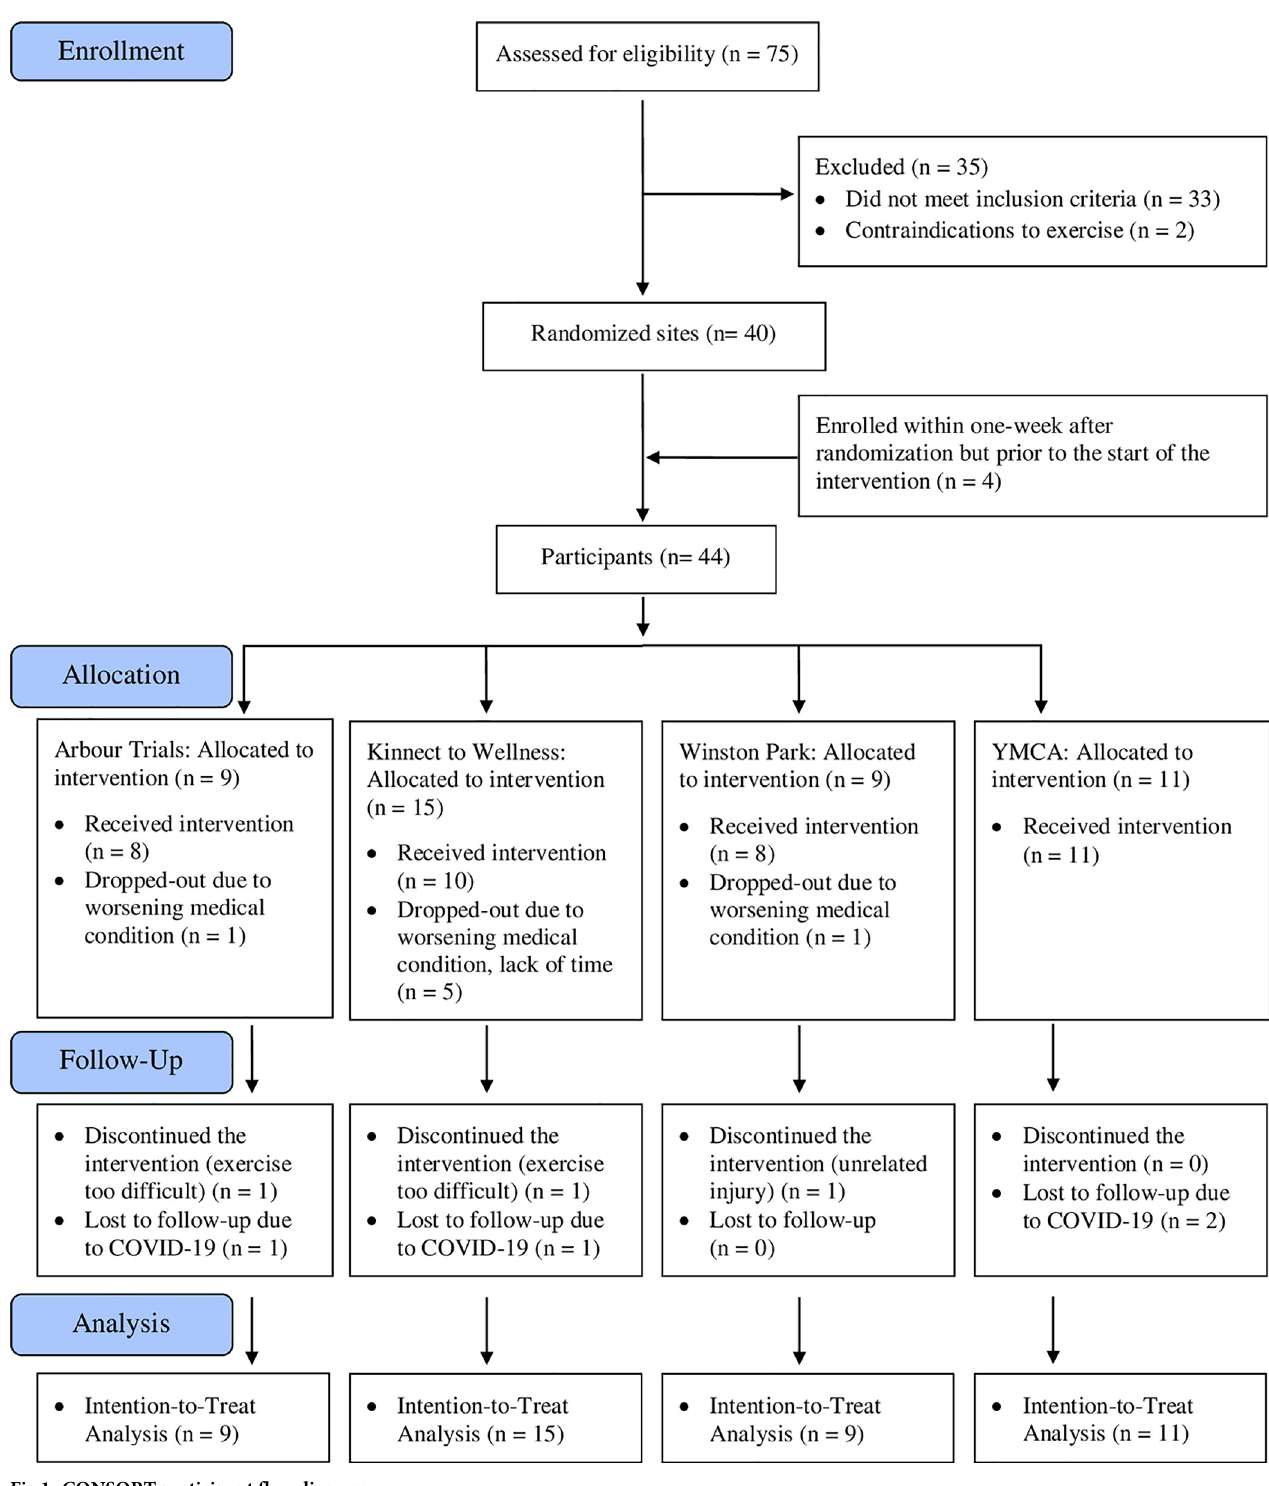
Fig 1. CONSORT participant flow diagram.